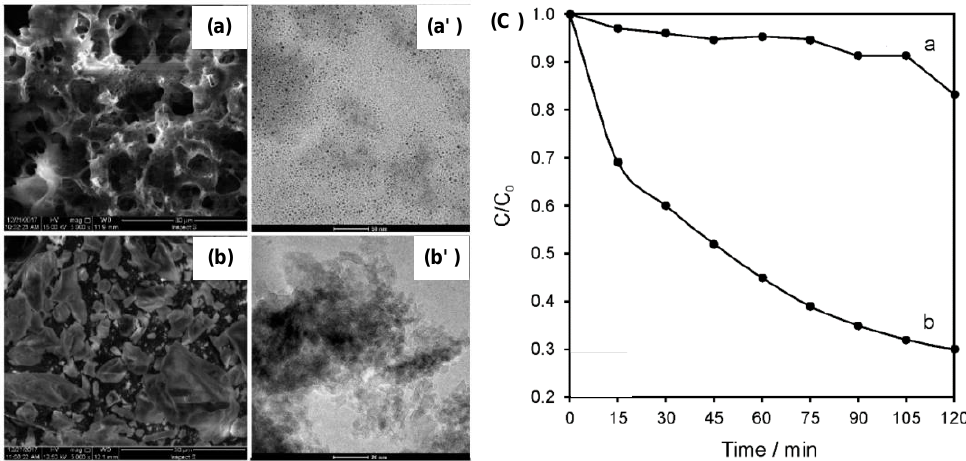
Figure 7. ( a , b ) SEM, ( a’ , b’ ) TEM of pristine GQDs and NiAl 2 O 4 / GQDs composite, respectively. ( c ) Photodegradation performances of NiAl 2 O 4 (line a) and NiAl 2 O 4 / GQDs composite (line b) over the Rhodamine B (RhB). Adapted with permission from Reference [136]. Copyright (2019) MDPI AG.